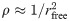
(A) Two cells, here depicted as spheres, pushed together by a force F. (B) Schematic of model geometry. Both cells have radius rcell much larger than the cell-cell separation distance (left). We assume the cells are held apart by nonspecific adhesion molecules with size Δz∞, which we refer to as the far-field separation. Near the receptor, there is a region free of nonspecific adhesion molecules of radius rfree, which is related to the surface density of non-specific adhesion molecules ρ≈1/rfree2. The membrane separation distance at the receptor is Δz0. In simulations with active forces, the force F is applied to a circular area of the top membrane with radius a.